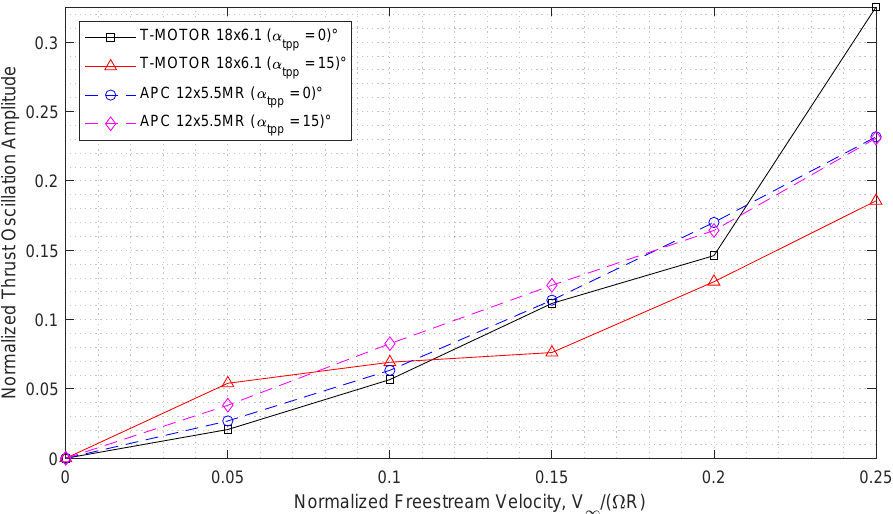
Figure 14. Normalized thrust oscillation amplitude vs. normalized freestream velocity as predicted with the DDE